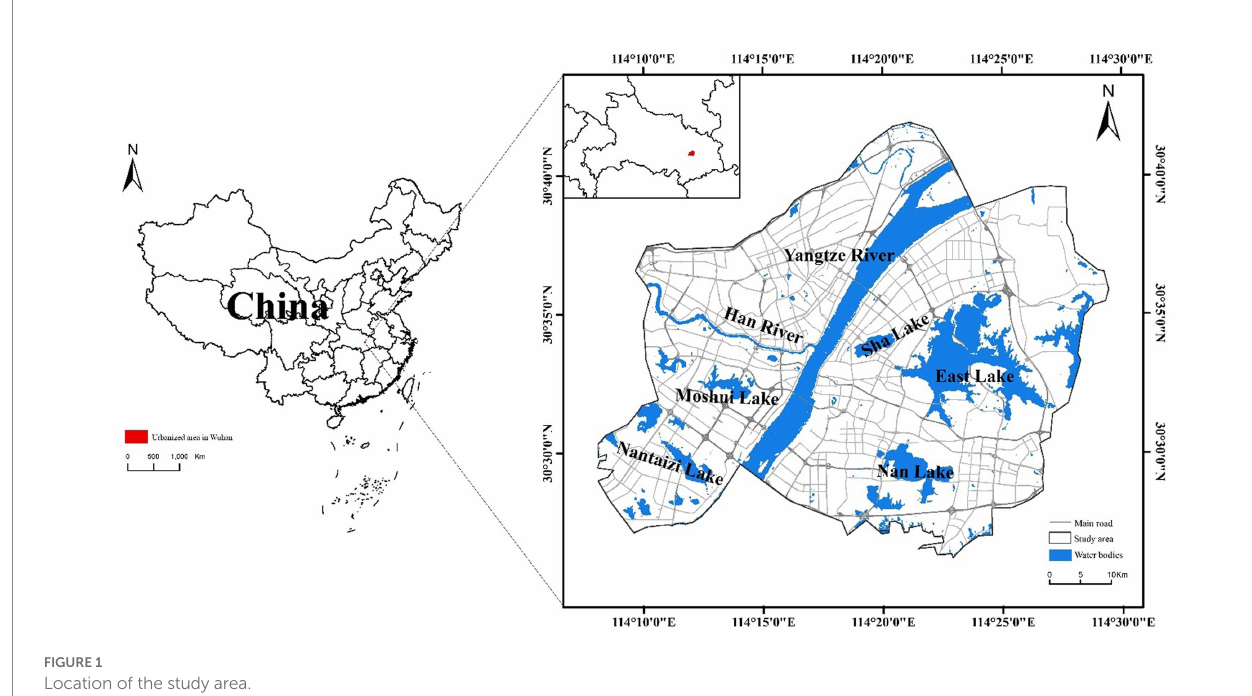
FIGURE 1 Location of the study